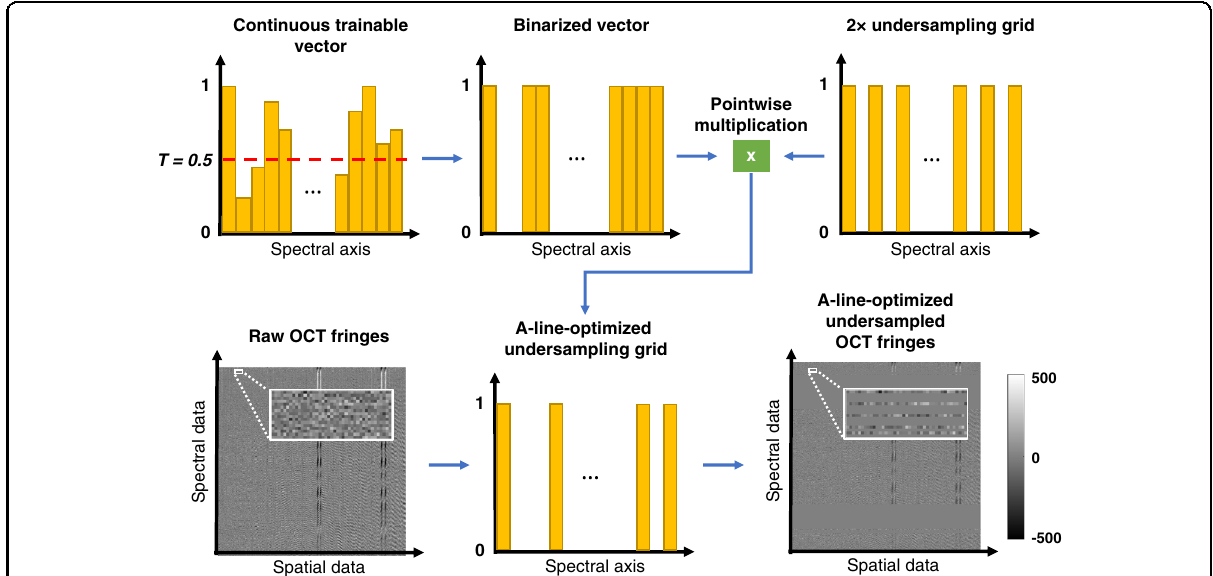
Fig. 8 Schematic of the A-line-optimized spectral undersampling method. A continuous, trainable vector was initialized and then binarized by a rounding function with a threshold of T = 0.5. The pointwise multiplication of the binarized vector and a regular 2× undersampling spectral grid forms the A-line-optimized undersampling grid, which was then applied to raw OCT fringes to generate undersampled fringes with N spec < 640. After the training process, the converged A-line optimized undersampling grid is shown in Supplementary Fig.